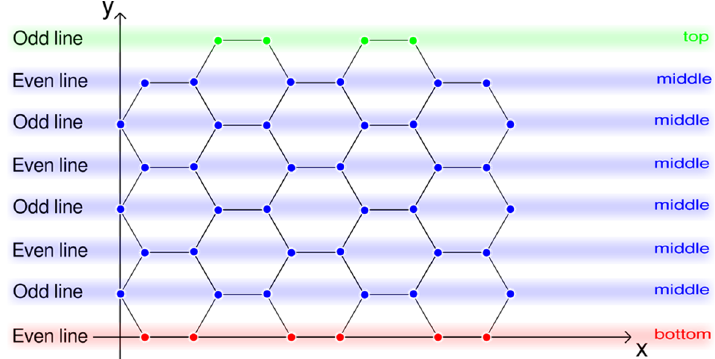
Figure 3. The construction process of the graphene sheet.